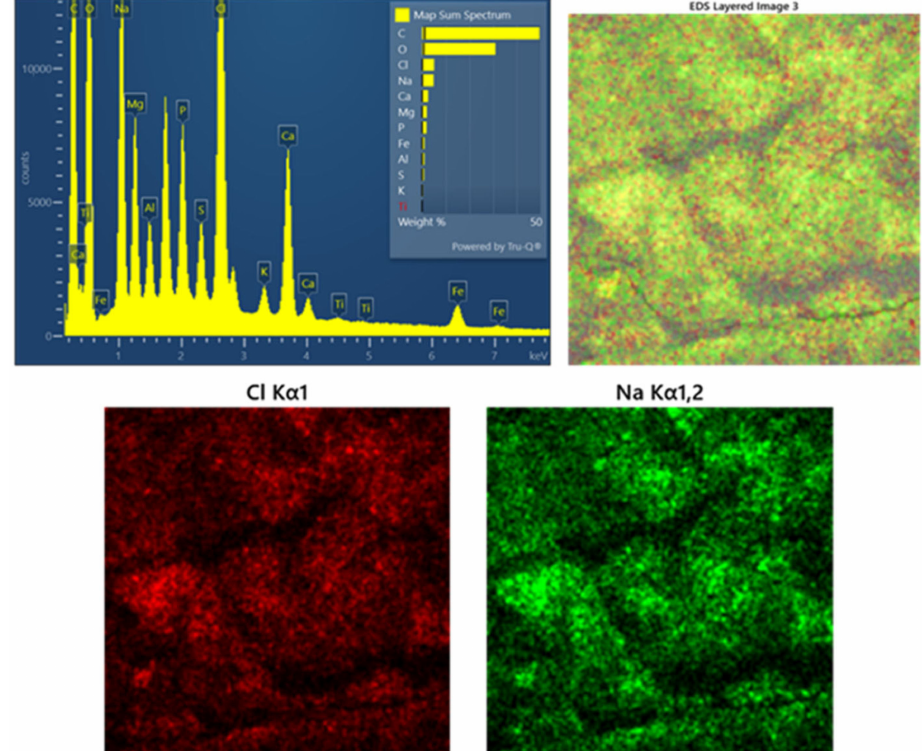
Figure 7. EDX spectrum obtained sample S1 ( top left ), related to the spatial distribution on a wide area of the sample of the different elements contributing to its composition ( top right ). The yellow color assigned to NaCl is due to the RGB superposition of the signals from Cl (in red, bottom left ) and Na (in green, bottom right